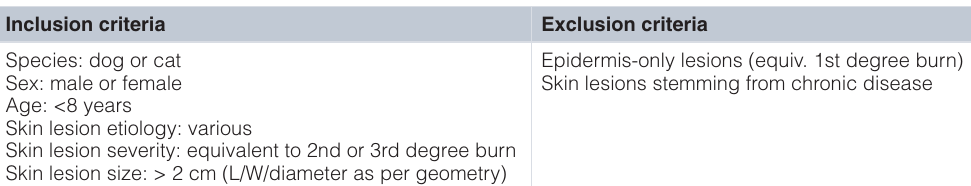
Table 1. Eligibility criteria for the present study.